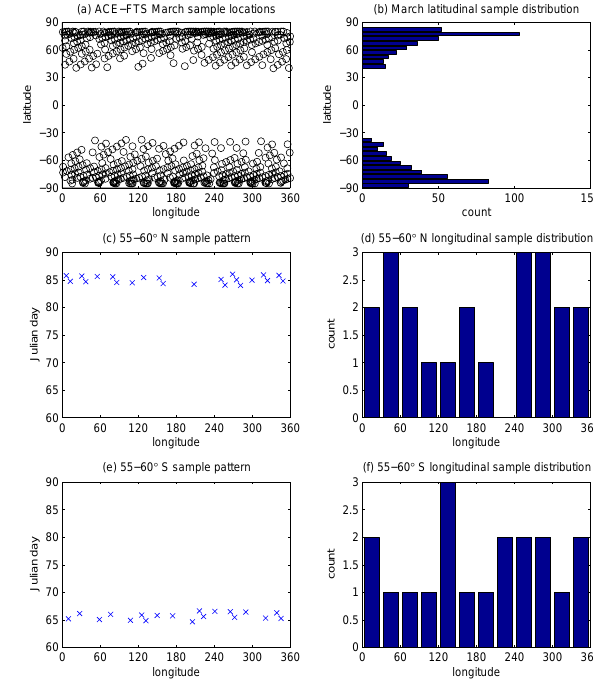
Fig. 2. MIPAS-LR March sampling, approximating MIPAS sam- pling from January 2005 until mission conclusion. (a) Example daily sampling spatial pattern, (b) monthly sample counts per 5 ◦ latitude bin, (c) time, longitude pattern of samples and (d) zonal sample distribution for the 55–60 ◦ N latitude bin, (e) time, longi- tude pattern of samples and (f) zonal sample distribution for the 55–60 ◦ S latitude bin.